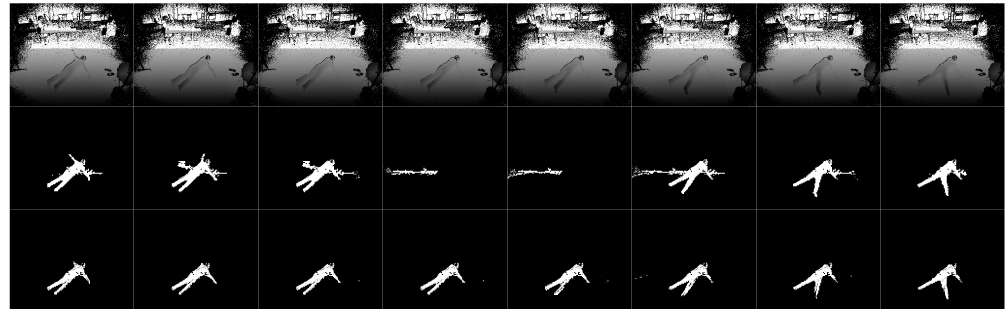
Figure 5. Experimental results of human segmentation. First row is depth images, second row is human segmentation using Kinect SDK and the third row is human segmentation using